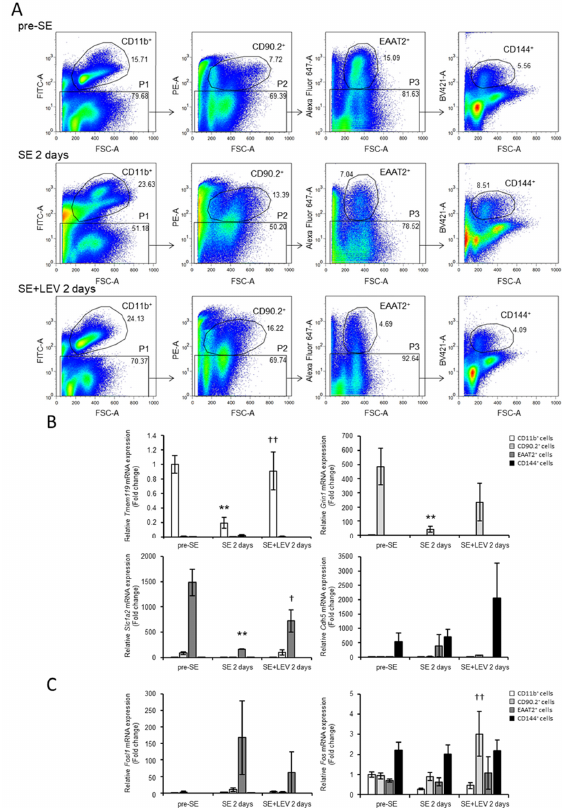
Figure 5. Identification of hippocampal cells expressing Fosl1 after PILO-SE. ( A ) Representative plots of fluorescence-activated cell sorting from the hippocampus. The hippocampus was collected from PILO-SE mice at 2 days post-SE in mice treated with LEV or untreated and from pre-SE mice. Cells prepared for FACS analysis were first gated based on CD11b-FITC fluorescence intensity as CD11b + or CD11b − . Next, CD11b − cells (P1) were resolved according to CD90.2-PE fluorescence. CD90.2 − cells (P2) were further divided as EAAT2 + or EAAT2 − according to Alexa Fluor 647 fluorescence, and EAAT2 − cells (P3) were finally subdivided as CD144 + or CD144 − according to CD144-BV421 fluorescence. These four populations (CD11b + , CD90.2 + , EAAT2 + and CD144 + ) were collected by FACS for analysis of transcript expression levels using real-time PCR. ( B ) Real-time PCR analysis of gene markers of microglia ( Tmem119 ), neurons ( Grin1 ), astrocytes ( Slc1a2 ) and vascular endothelial cells ( Cdh5 ) of four FACS-sorted populations. ( C ) Real-time PCR analysis of Fosl1 and Fos expression levels of four FACS-sorted populations. The values were normalized relative to the β -actin ( Actb ) mRNA level and then divided by those of the control group (CD11b + cells of pre-SE) to calculate the relative mRNA levels. All data points represent the mean ± SEM of at least three independent experiments ( n = 3–7). Data were analyzed for significant differences by one-way ANOVA and Tukey’s post-hoc test. Results with p values < 0.05 were considered statistically significant. ** p < 0.01 vs. pre-SE mice, †† p < 0.01, † p < 0.05 vs. without post-SE